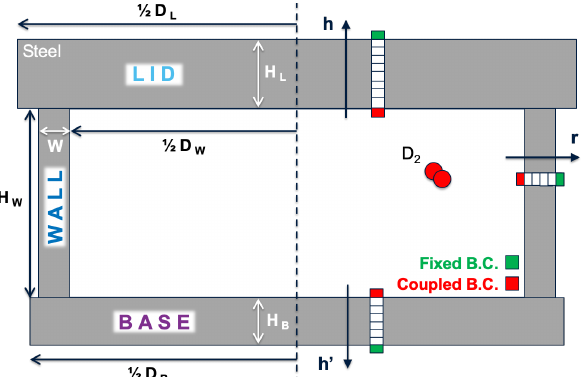
Figure 5. Schematic of the VST Upper Chamber (UC) as modelled using a quasi-2D modelling approach. The dashed line indicates an axis of cylindrical symmetry. On the left, simplified chamber dimensions used in the model ( D L = 305.0, D W = 250.0, D B = 270.0, H L = 26.0, H W = 95.0, H B = 20.0, W = 2.0; all in mm). On the right, a diagram of the diffusion channels foreseen in the simulation (two cartesian vertical, h and h (cid:48) , and a cylindrical radial, r ). Boundary conditions are indicated by color: external Fixed BC (in green ) and internal Coupled BC (in red